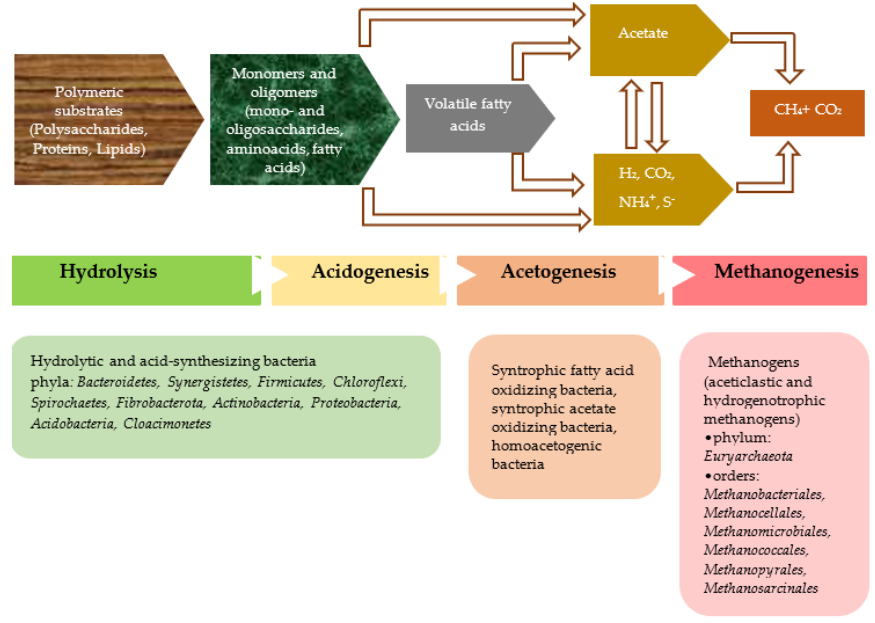
Figure 4. The main taxa of bacteria in the four stages of anaerobic digestion.